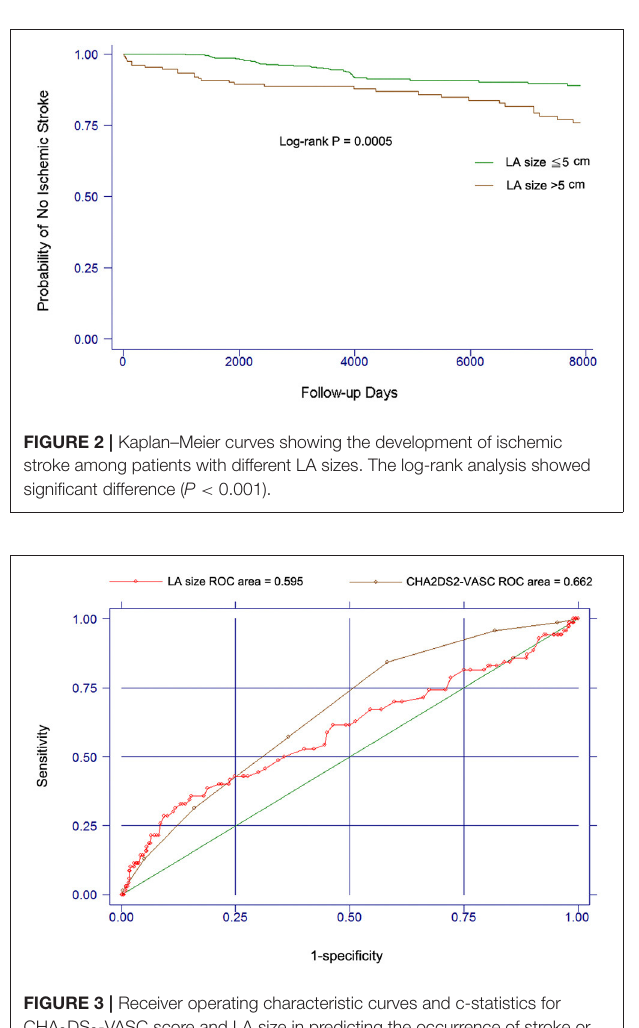
develop ischemic stroke or TIA than those with LA size ≦ 50 mm (log-rank P = 0.0005).